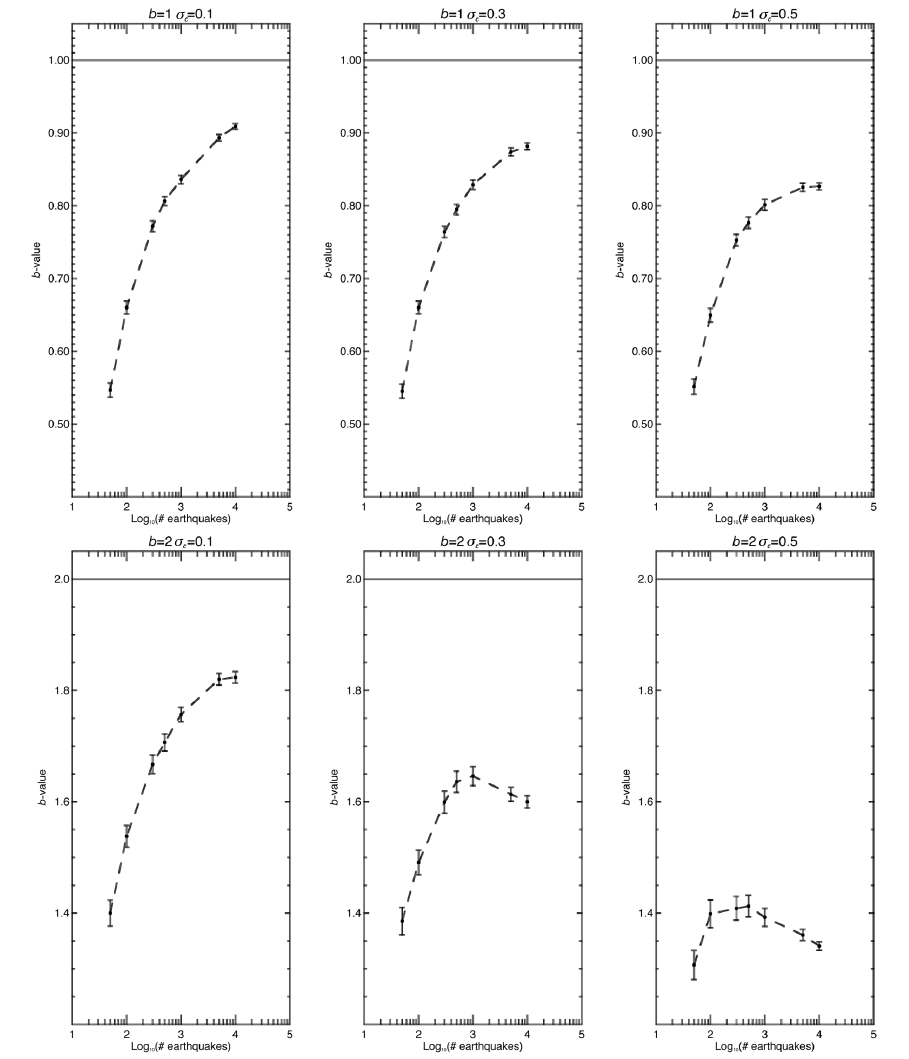
Fig. 6. Averages of b t (dashed lines) calculated through binned LS technique in 1000 synthetic catalogs as a function of the catalog size, for the cases b = 1 ( top ) and b = 2 ( bottom ). The magnitudes have measurement errors of standard deviation σ ε = 0.1, 0.3, 0.5 (from left to right ). At each average is attached the 95% confidence inter- val. The solid line represents the true b